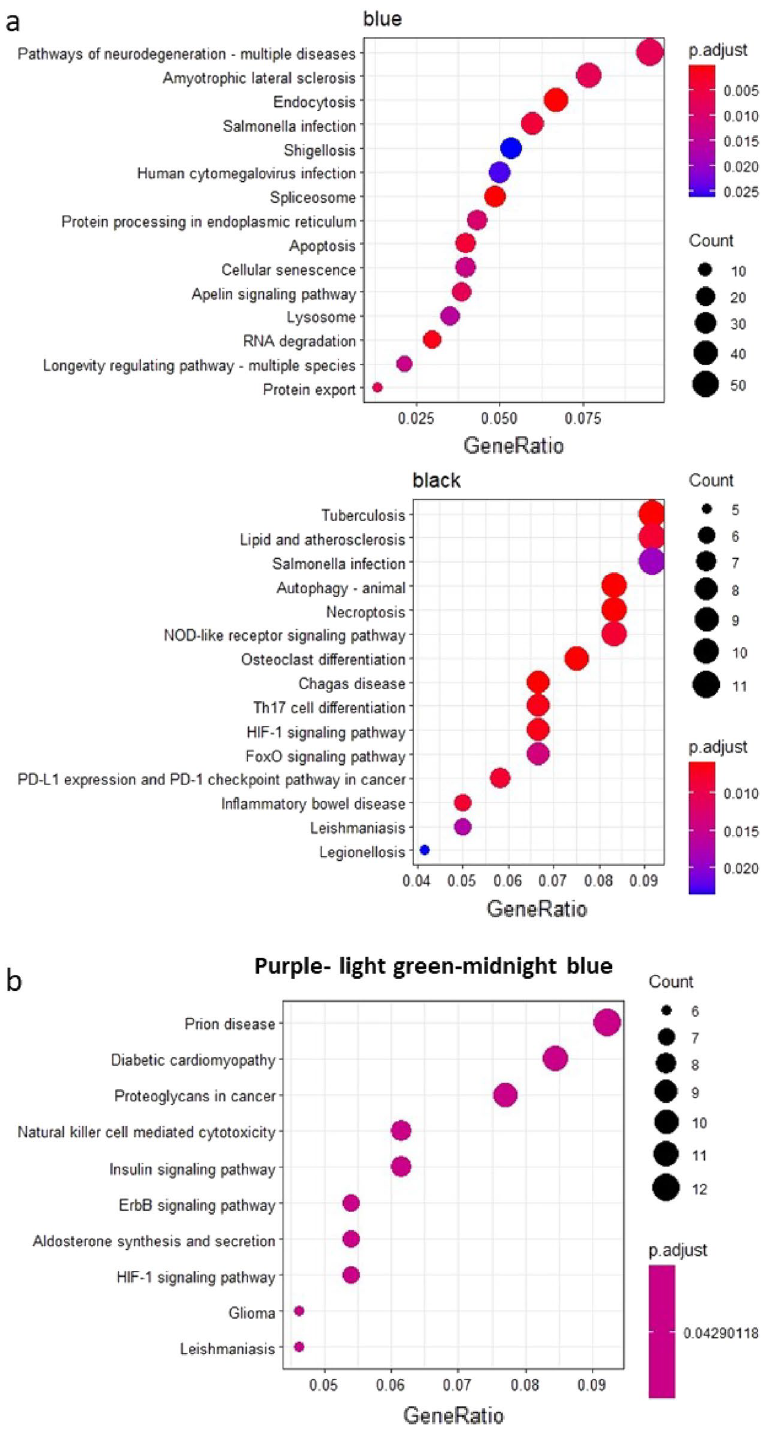
Figure 3. KEGG enrichment analysis of main modules. ( a ) The top 15 terms of KEGG enrichment in ALS- related modules; blue and black, separately. ( b ) Enrichment analysis of FTD-related modules including purple, light green, and midnight